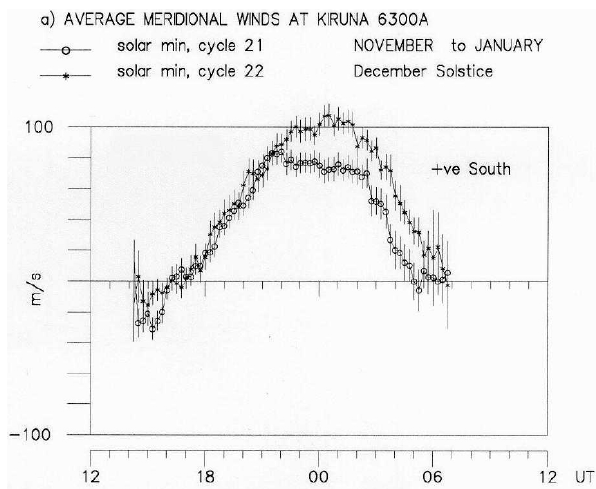
Fig. 1. A comparison of average meridional winds at solar mini- mum from FPI measurements (north look direction) at Kiruna for 2 different solar cycles (21 and